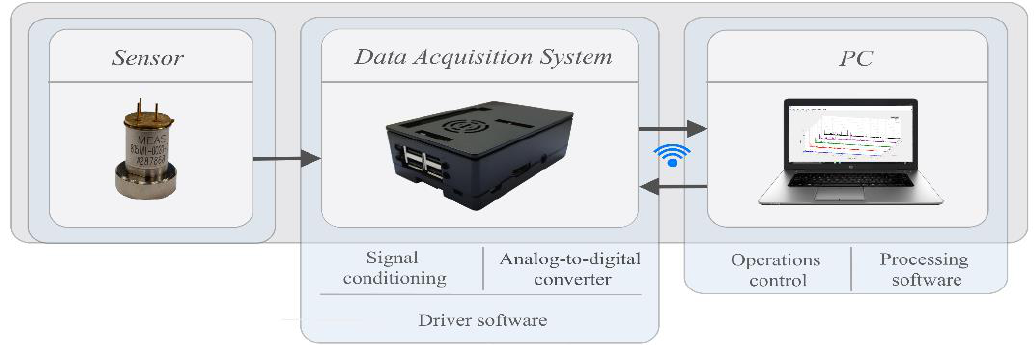
Figure 5. Components of the data recording system.